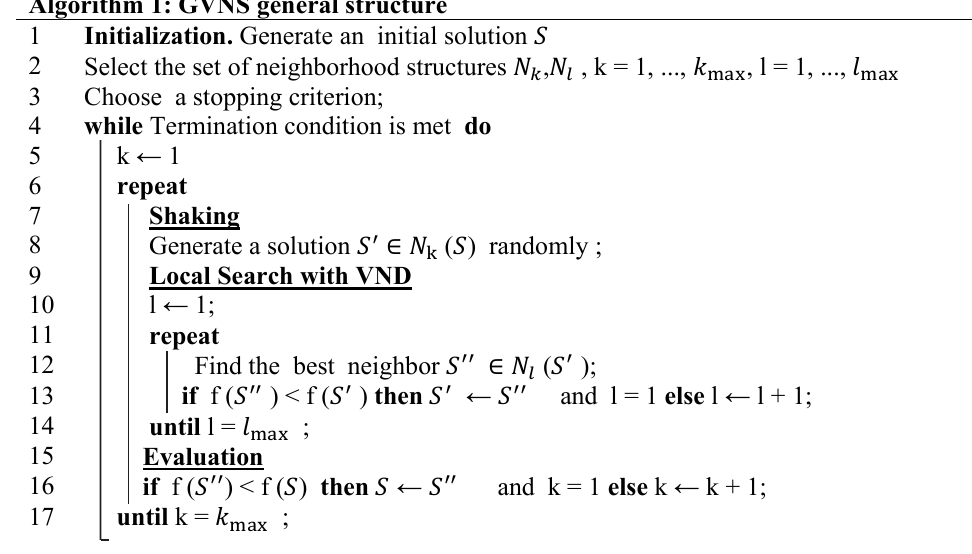
Algorithm 1: GVNS general